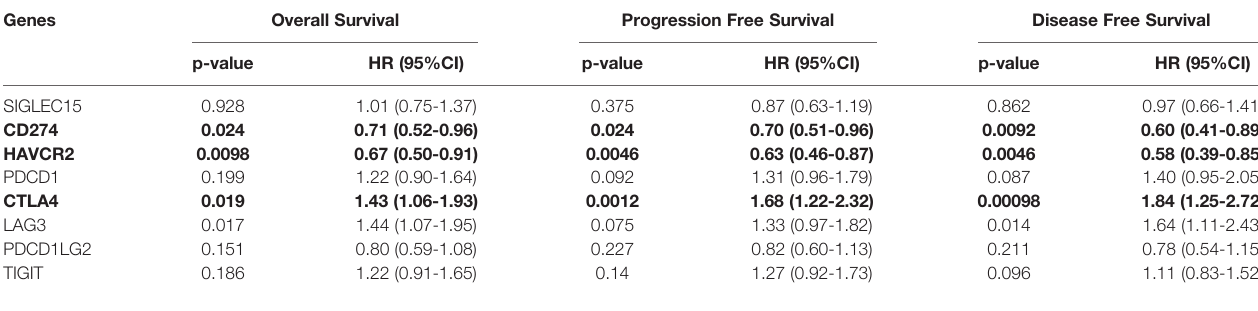
TABLE 1 | Prognosis analysis of immune checkpoints in KIRC.